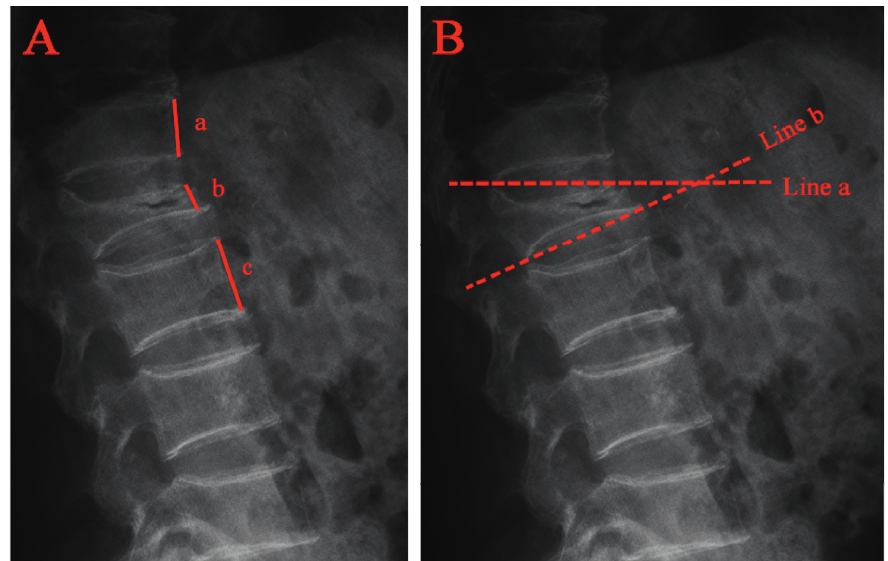
Figure 3: Radiographic evaluation of compressed vertebrae. (a) The anterior vertebral height ratio (AVHR) was defined as the height of the anterior wall of the compressed vertebral body (B)/(the height of the anterior wall of the upper vertebral body (A)+the height of the anterior wall of the lower vertebral body (C)) × 2. (b) Cobb angle was defined as the angle formed by the upper endplates (line a) and lower endplates (line b) of the fractured vertebral body.